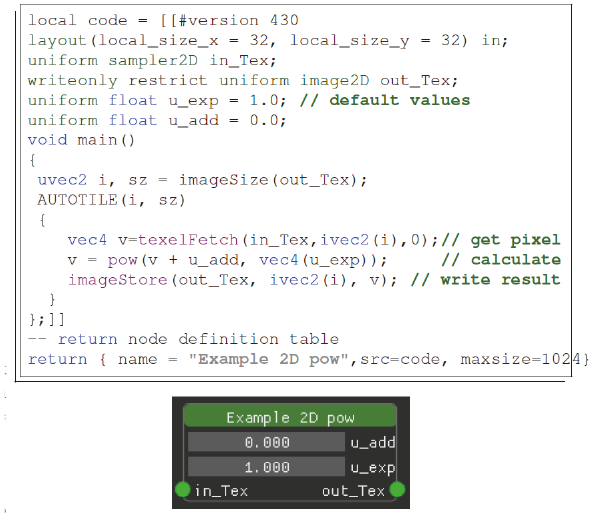
Figure 5: A minimal working example. This node calculates ( V + add ) exp for every pixel and color channel in a 2D image, resulting in contrast enhancement. The only Lua code is the definition table in the last line; the rest is GLSL embedded in a Lua string. Missing interface functions are automatically induced. The resulting graphical representation is displayed in the small box/node (dark background, green title bar). More information can be found in the supplement (available